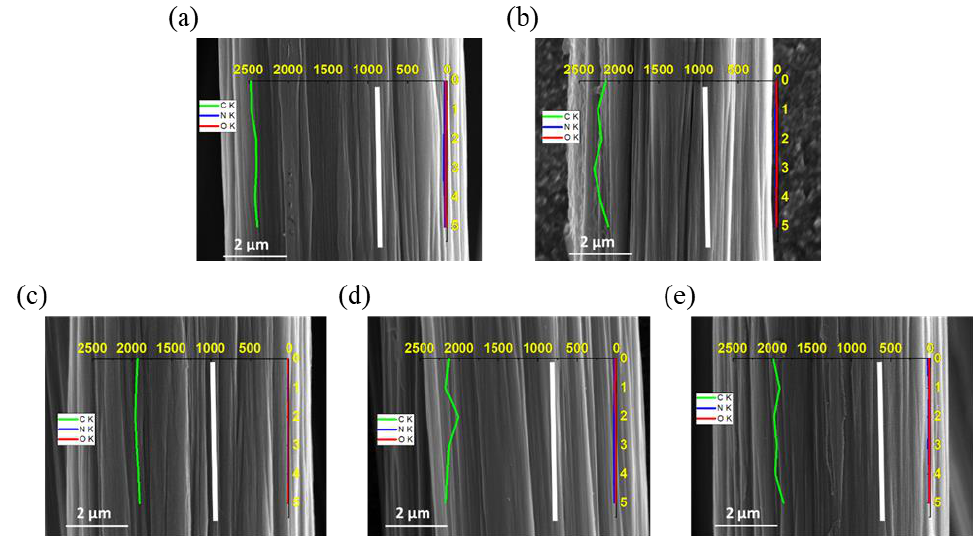
Figure 8. FE−SEM images and SEM−EDX line spectra of elemental carbon (green line), nitrogen (blue Figure 8. FE-SEM images and SEM-EDX line spectra of elemental carbon (green line), nitrogen (blue line), and oxygen (red line) in ( a ) C−CFs and ( b ) de−CFs, as well as ( c ) PI 0.5 wt%, ( d ) PI 1.0 wt%, line), and oxygen (red line) in ( a ) C-CFs and ( b ) de-CFs, as well as ( c ) PI 0.5 wt%, ( d ) PI 1.0 wt%, and and ( e ) PI 1.5 wt% PI−sized CFs. ( e ) PI 1.5 wt% PI-sized